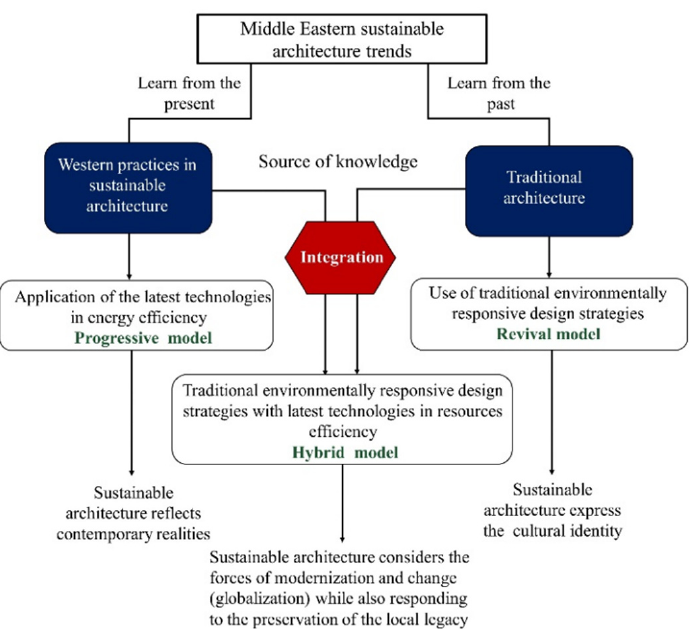
Figure 1. The sustainable housing trends and models in the Middle Eastern region (authors).